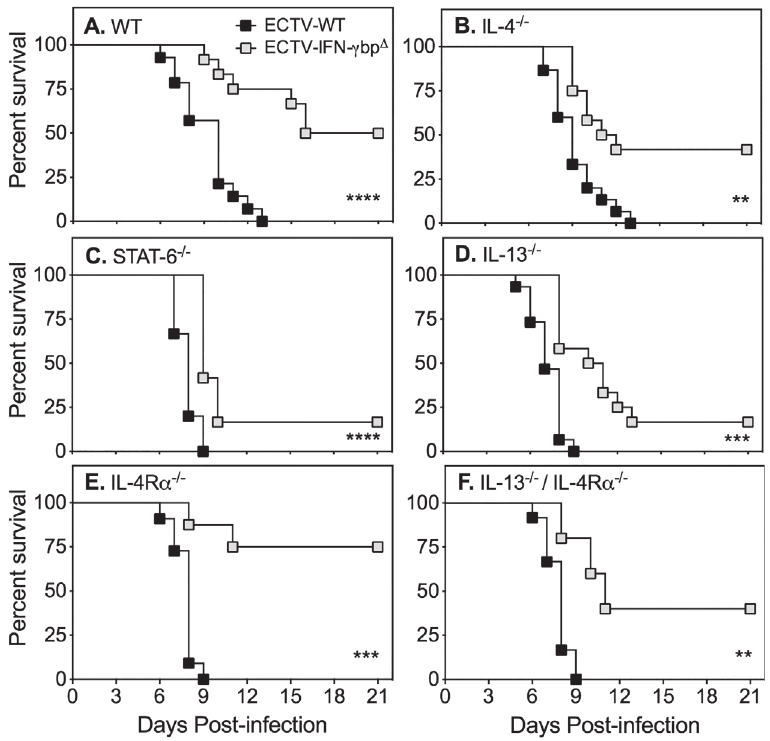
Fig 1. Response of WT and GKO BALB/c strains to infection with ECTV-WT or ECTV-IFN- γ bp Δ . Groups of female mice were infected with ECTV-WT or ECTV-IFN- γ bp Δ . Mice were monitored daily for 21 days for disease signs. Data shown are combined results obtained from two separate experiments in which 5 – 15 mice per strain were used (S2 Table). P values for survival proportions were obtained by using Kaplan-Meier Log rank statistical test: ** , p < 0.01; *** , p < 0.001; **** , p < 0.0001. The survival rates of WT mice compared to GKO mice infected with WT or mutant virus are presented in S5 and S6 Figs., respectively and the statistical analysis presented in S2